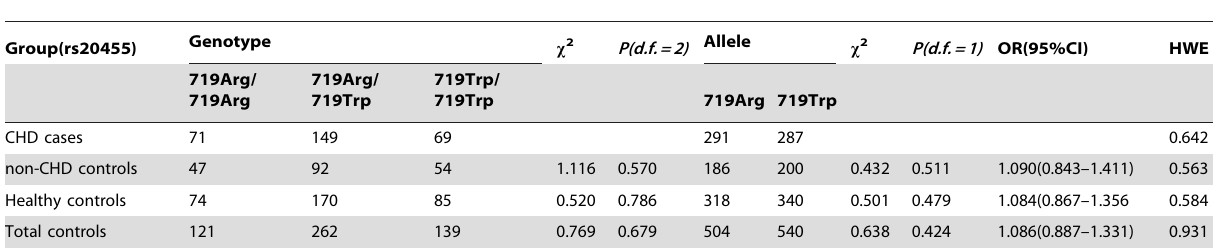
Table 1. Genotype and allele of Trp719Arg in case and control groups.